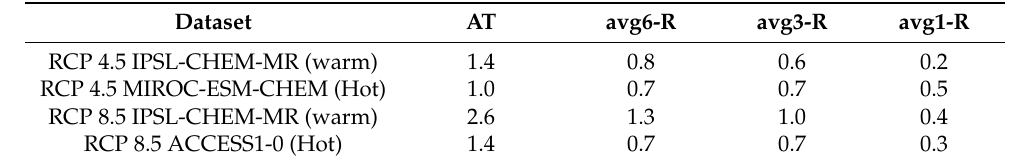
Table 16. Effects of ambient temperature on water temperature for Roode Elsberg dam from 2012–2053 at different RCPs, recorded water level.